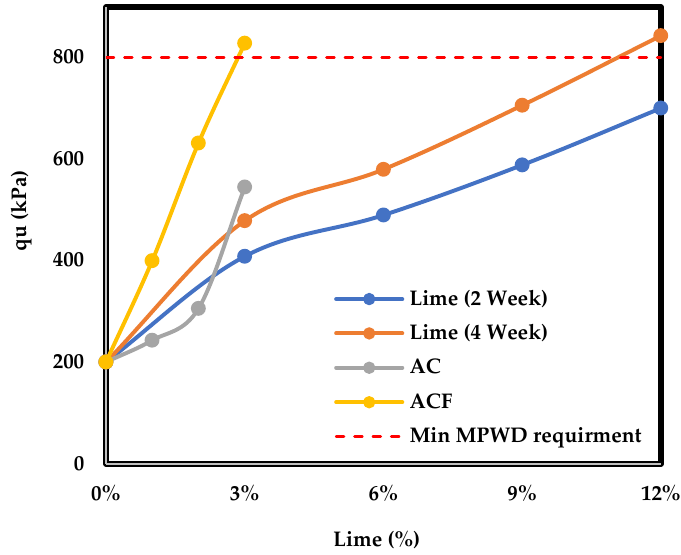
Figure 7. The compressive strength value for different lime and AC contents.